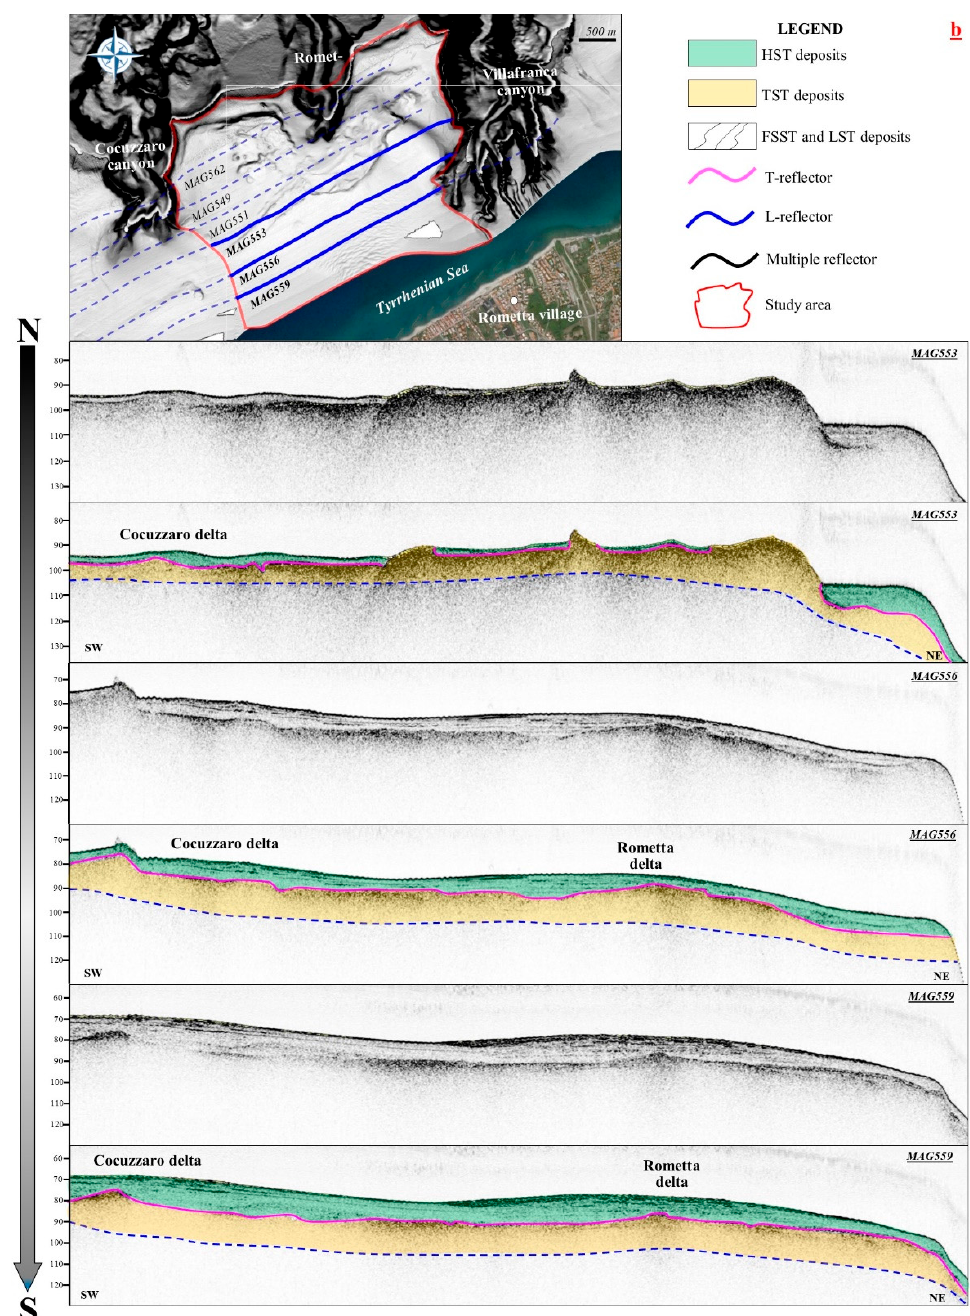
Figure 3. ( a ) Location and interpretation of three CHIRP seismic profiles (MAG562, MAG549 and MAG551,) analyzed for the seismic-stratigraphic reconstruction of the northern portion of the study area. ( b ) Location and interpretation of the CHIRP seismic profiles (MAG553, MAG556 and MAG559) analyzed for the seismic-stratigraphic reconstruction of the southern portion of the study area. The acronym MAG is equivalent to “Marine Geohazards along the Italian Coasts project”.